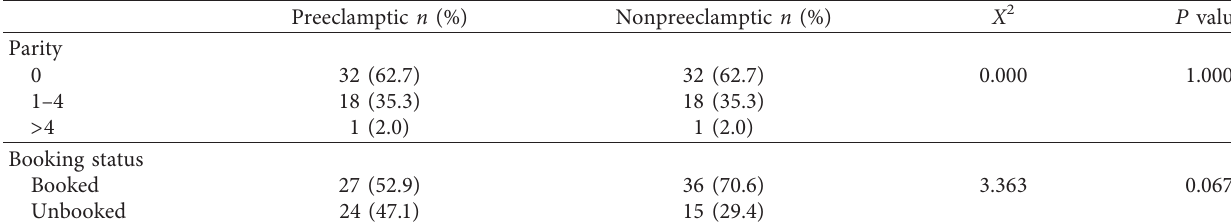
Table 2: Parities and booking status of